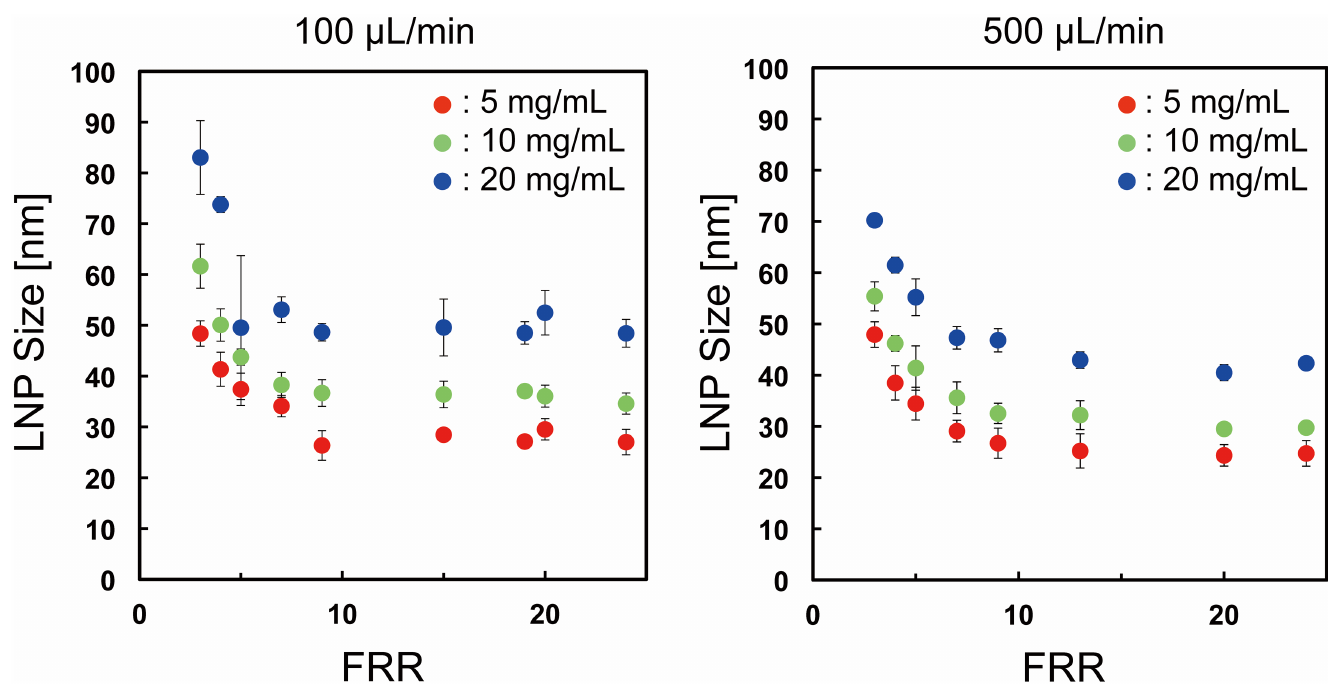
Fig 3. The effect of lipid concentration on LNP size under different flow conditions. The error bars representthe standard deviationcalculatedfrom repeatingeach LNP formation experiment at least three times.